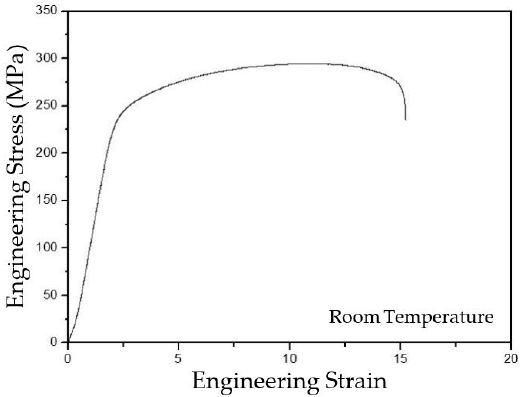
Figure 4. Stress–strain curve at strain rate of 10 − 3 s − 1 for alloy ZK60.